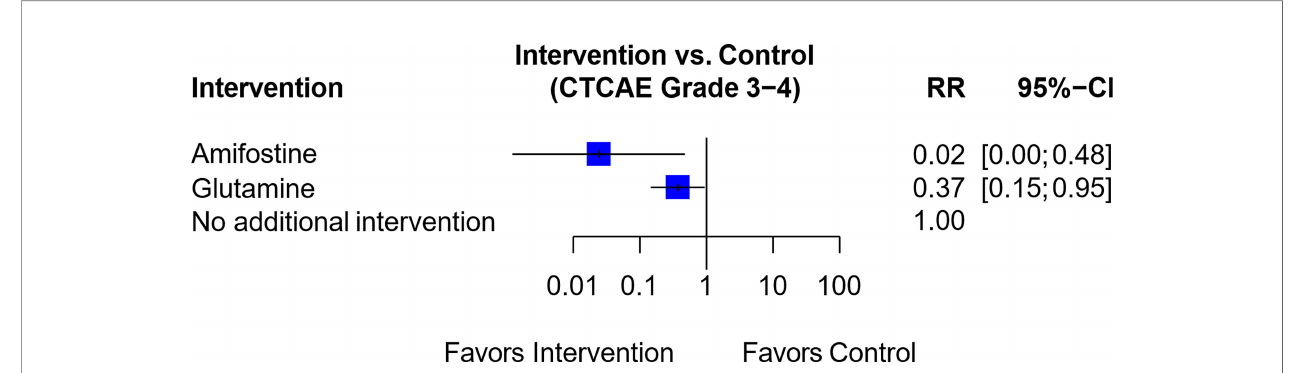
FIGURE 6 | Forest plot for network analysis comparing Amifostine, Glutamine and control (no additional intervention), on the risk of CTCAE Grade 3-4 OIPN. Risk ratio comparing amifostine to no additional intervention was derived indirectly from network meta-analysis, while the risk ratio comparing glutamine against no additional intervention was derived directly from original trial